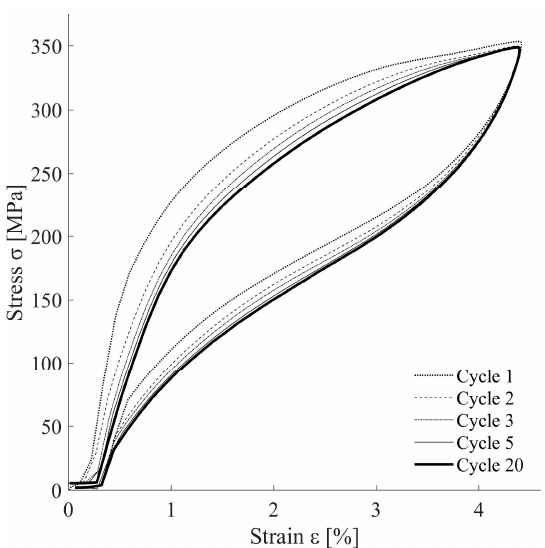
Figure 8. Hysteresis loops of specimen S 11 .